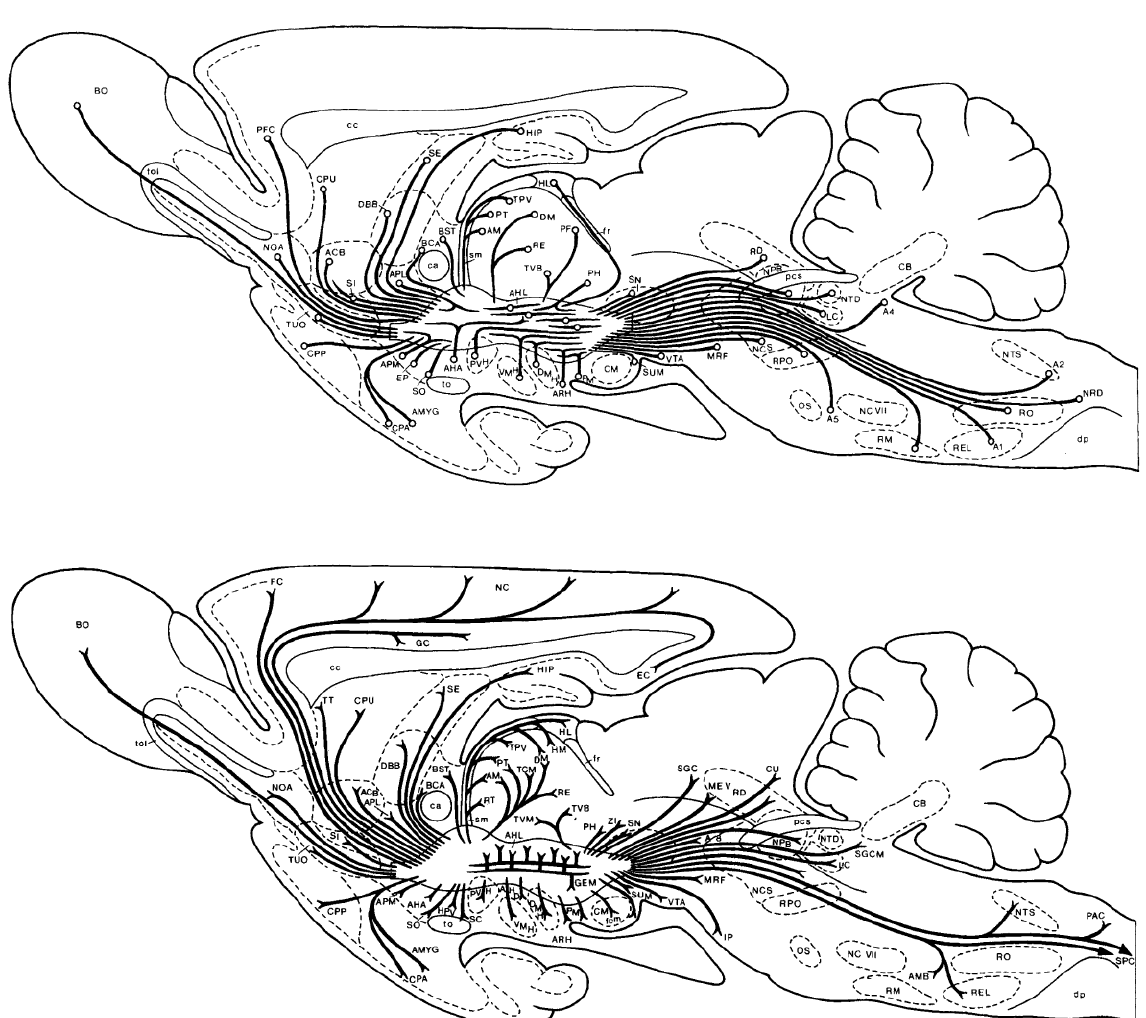
Figure 5. Inputs to ( top ) and outputs from ( bottom ) the rat MFB, from [91]. The notion that signals from the myelinated axons subserving MFB self-stimulation reach the behavioral final-common path for reward pursuit in parallel to those from dopamine neurons (Figure 4) invites us to consider MFB outputs that extend beyond the midbrain region housing dopaminergic somata. Of particular interest are the branching projections described by Nauta and Domesick [92]. They note a large contingent of MFB axons that execute a turn in the VTA and pass caudo-laterally just above the SNc; a substantial subset of these fibers then execute another turn and head dorsomedially. Some terminate in the midbrain reticular formation, whereas others continue to course caudally into the ventral portion of the central grey. Fibers in a second more medial division pass through the VTA, and some reach the laterodorsal tegmental nucleus, ventral portion of the central grey, and locus coeruleus. Could axons in one or both branches contribute to the therapeutically beneficial effect of MFB stimulation in humans, in parallel to, or even instead of, the contribution of the MFB inputs to the midbrain dopamine neurons? Along the trajectories of the branches described by Nauta and Domesick, we have recorded compound action potentials elicited by rewarding stimulation at the lateral hypothalamic level of the MFB; recovery from refractoriness in the fibers from which the recordings were obtained corresponds to psychophysical measurements derived from the behavior of the rats